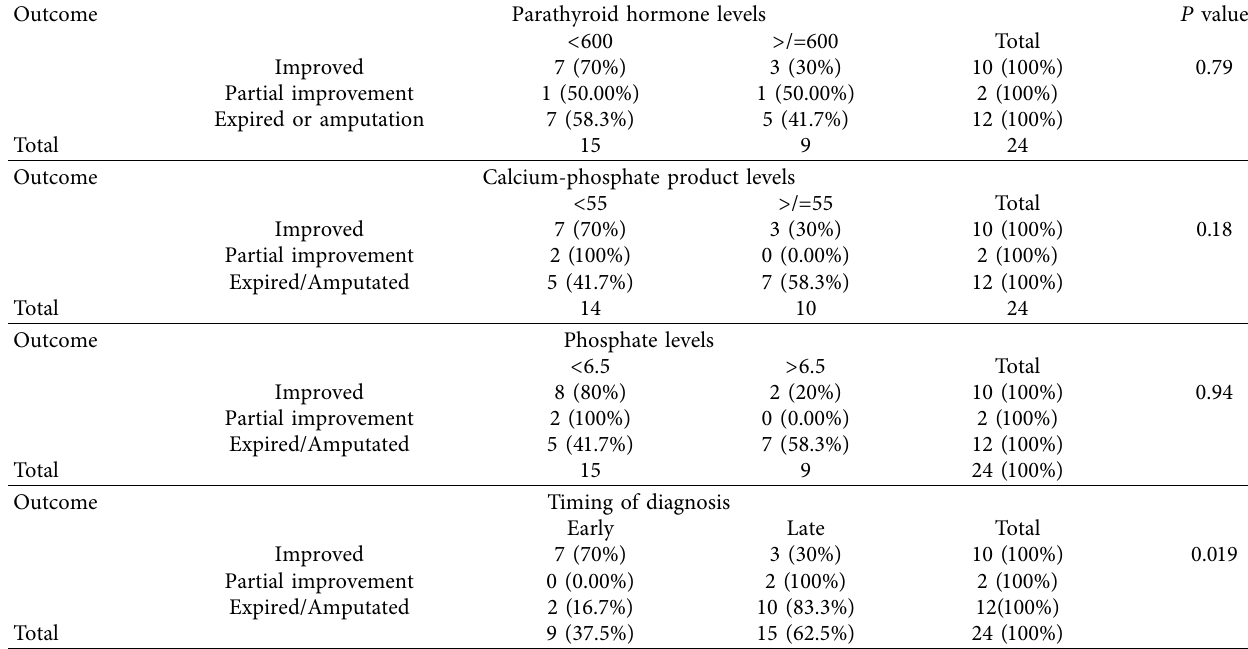
Table 4: The outcome of calcific uremic arteriolopathy lesions in relation to the severity of hyperparathyroidism, levels of calcium- phosphate products, the degree of hyperphosphatemia, and the timing of the diagnosis. Outcome Parathyroid hormone levels P value